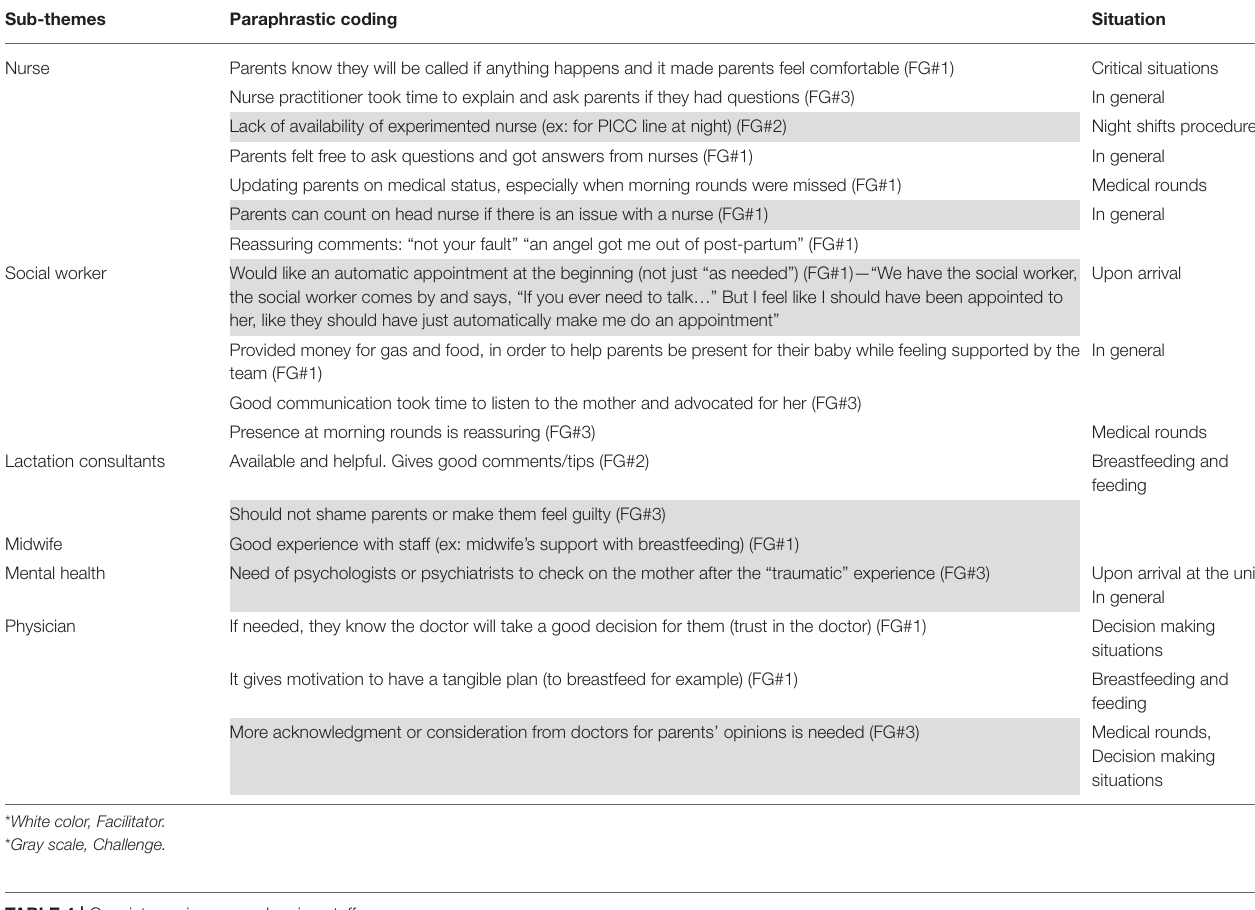
TABLE 4 | Consistency in care and caring